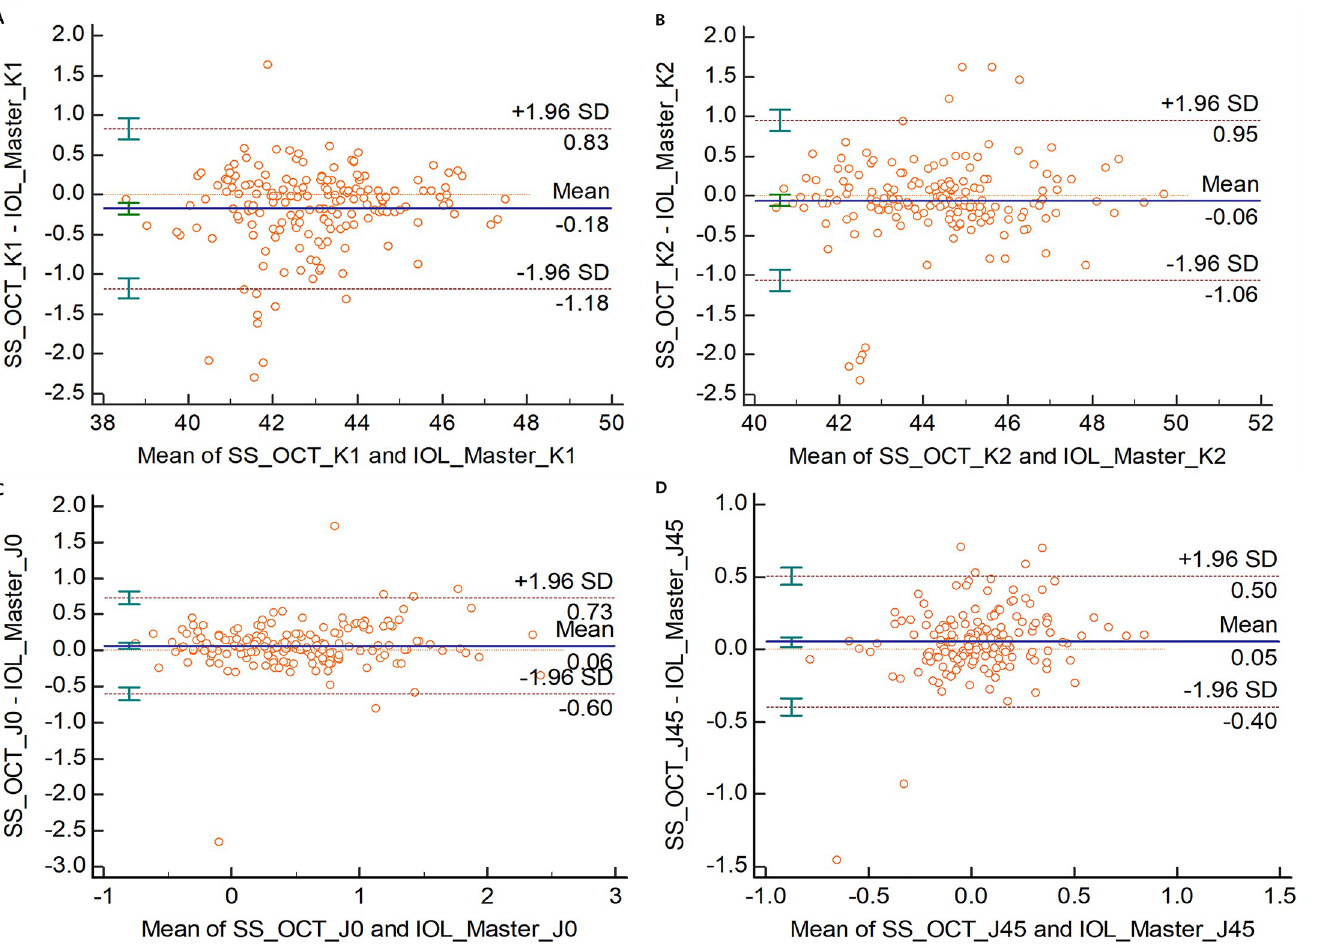
Fig 2. Bland–Altman plots of agreement in the evaluation of the corneal curvature. (A) flat K (K1), (B) steep K (K2), (C) J0, (D) J45. The solid line shows the mean difference (bias). Upper and lower dashed lines imply 95% limits of agreement.